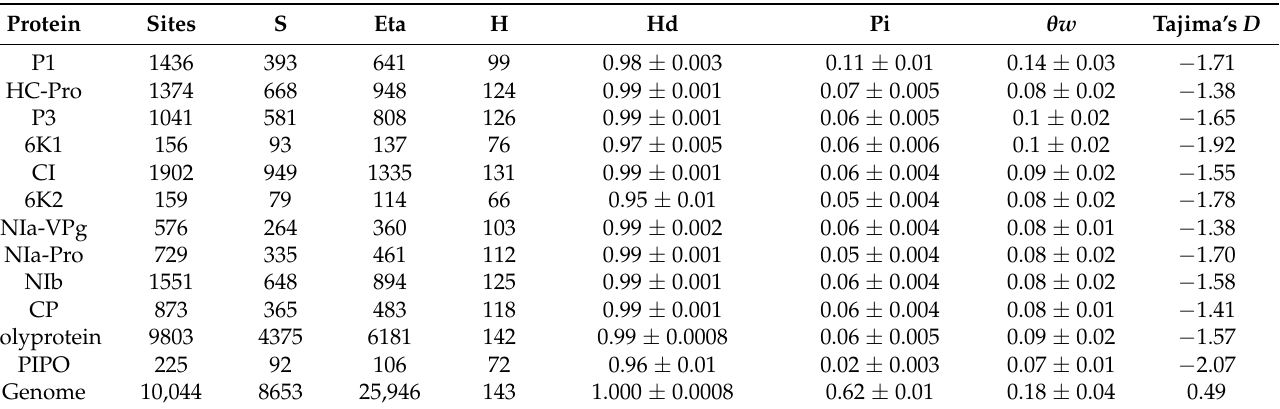
Table 1. Genetic diversity of 143 SMV genomes based on nucleotide sequences corresponding to individual